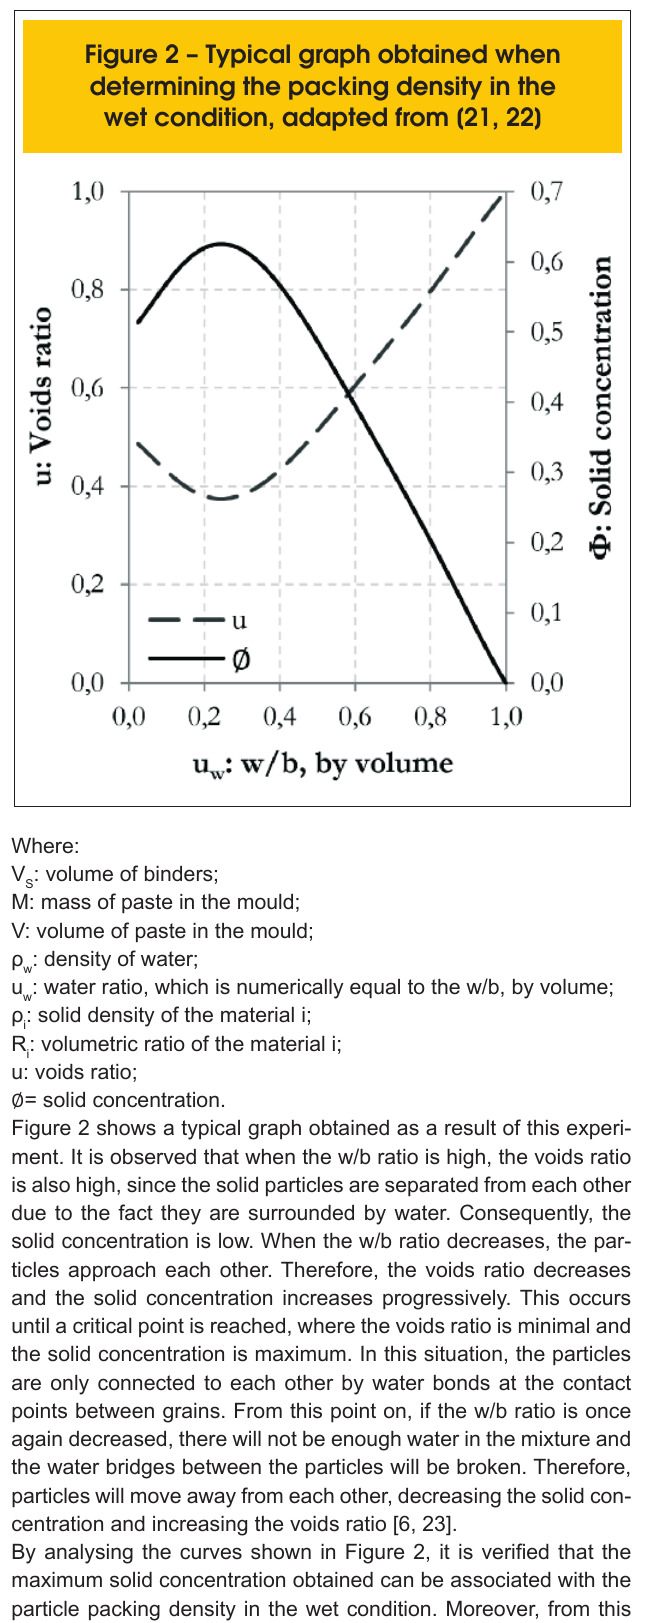
Figure 2 – Typical graph obtained when determining the packing density in the wet condition, adapted from [21, 22]